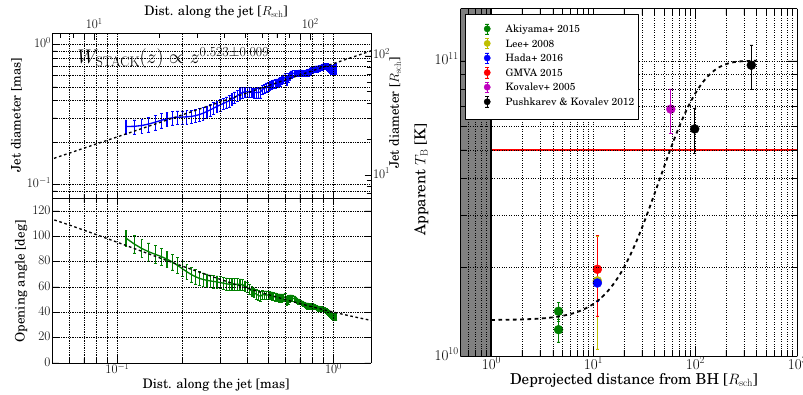
Figure 3. Left : the M87 inner jet collimation profile with the dashed grey lines indicating the model fitting to the data; Right : the frequency dependent brightness temperature evolution of the VLBI core displayed as function of the distance from the BH. The grey-painted region indicates 1 R sch , the red solid line the equipartition brightness temperature value of T B = 5 10 10 K, the symbols for the × origin of the data, including new Global Millimeter-VLBI Array (GMVA) data, and data from the literature ([5,11–14]). The dashed line sketches a jet acceleration